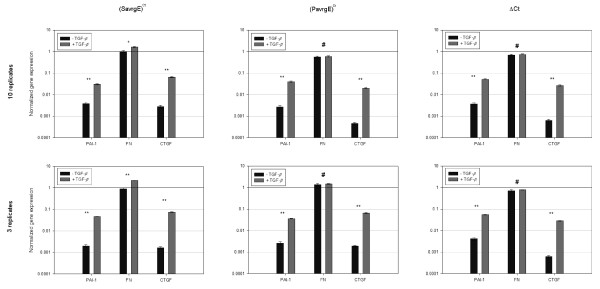
Comparison of the (SavrgE)Ct, (PavrgE)Ct and ΔCt methods to quantify gene expression regulation. cDNAs were prepared from RNA extracted from fibroblastic cells induced or not by TGF-β treatment, as described in the Materials and methods. Expression as determined from the mRNA levels of the plasminogen activator inhibitor 1 (PAI-1), fibronectin (FN) and connective tissue growth factor (CTGF) genes were normalized to those of the ribosomal L27 protein, used as an invariant internal reference. Normalized gene expression was calculated using the (SavrgE)Ct, (PavrgE)Ct or the ΔCt methods, as indicated, using either the complete set of 10 replicate assays (top histograms), or using just three measurements (first three assays of the series, bottom histograms). Error bars represent standard deviations on the normalized ratio. A t-test was performed on the normalized gene expression to check whether the expression were statistically different between the induced and the non-induced state (* = p < 0.05, ** = p < 0.001, # = p > 0.1).